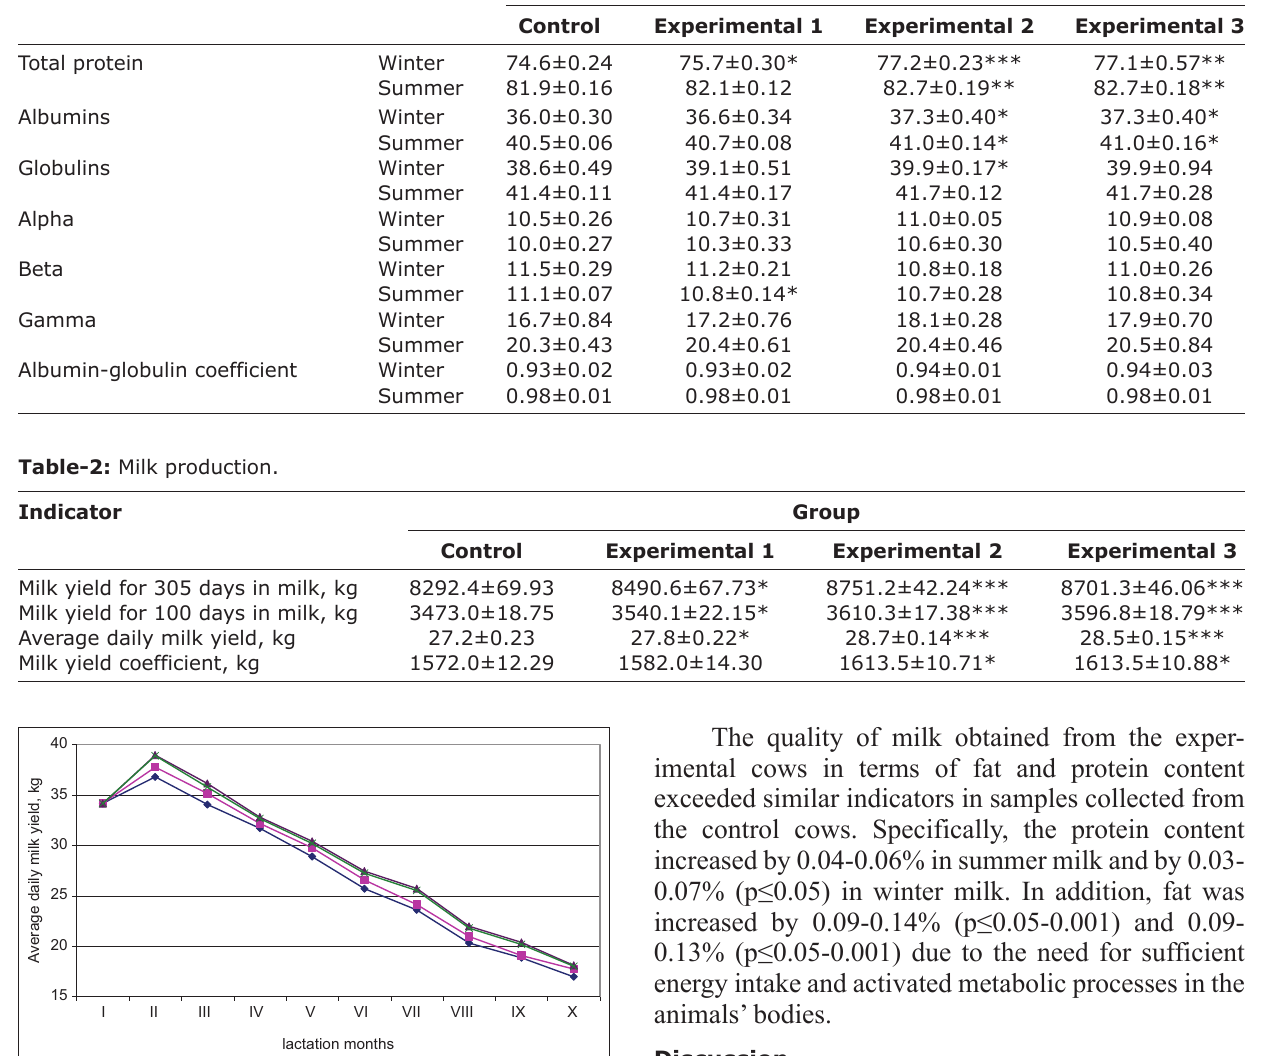
Table-1: Protein composition of blood serum, g/L (X±Sx). Indicator